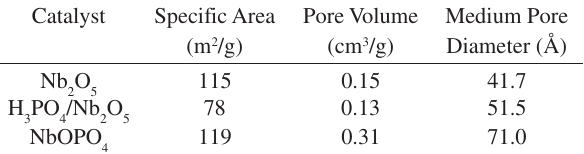
Table 1. Textural properties of the samples.